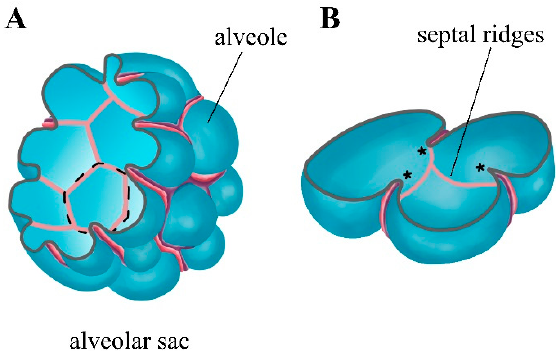
Figure 3. Cross-section of the alveola with a view of the secondary septa. α SMA fibers, marked in pink, and closely related elastin matrices, marked in purple, are expressed in an organized network, mimicking a “fishnet” pattern in the alveolar region. The alveolar epithelium is marked in blue. The black dotted line indicates the entrance alveolar ring (AER) ( A ). Septal ridges in 2D look like an assembly of α SMA fibers on the tips of secondary septa (asterisks) ( B ). The gray line imitates the cutting line. Redrawn from [39].